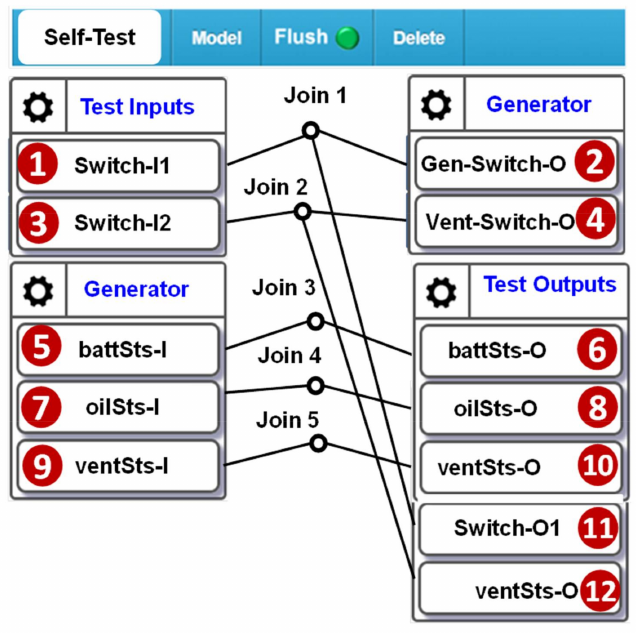
Figure 13. Self-test configuration for the generator.